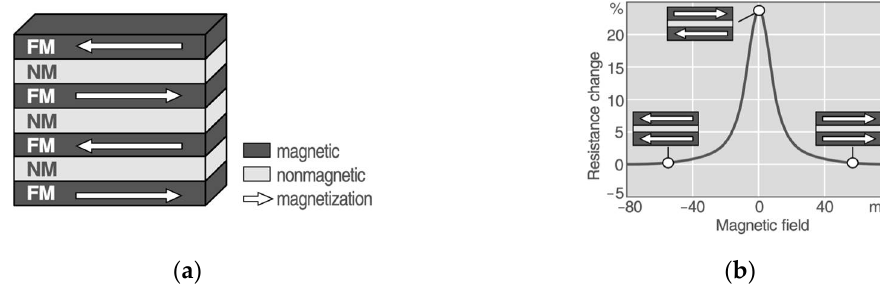
Figure 10. GMR sensor principle. ( a ) GMR multilayer structure with FerroMagnetic (FM) and Non FerroMagnetic (NM) layers; ( b ) Resistance characteristic according to an applied magnetic field, reproduced from [9]. Copyright 2007, Robert Bosch GmbH.